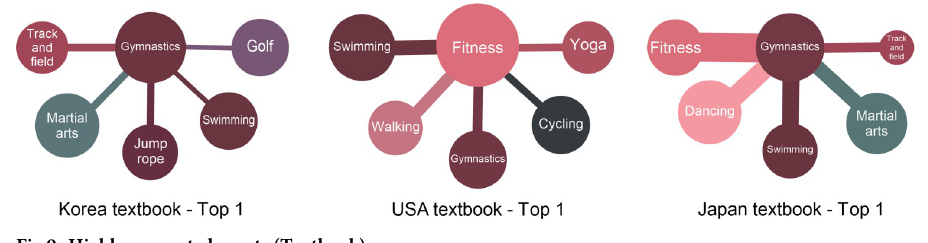
Fig 9. Highly connected sports (Textbook).